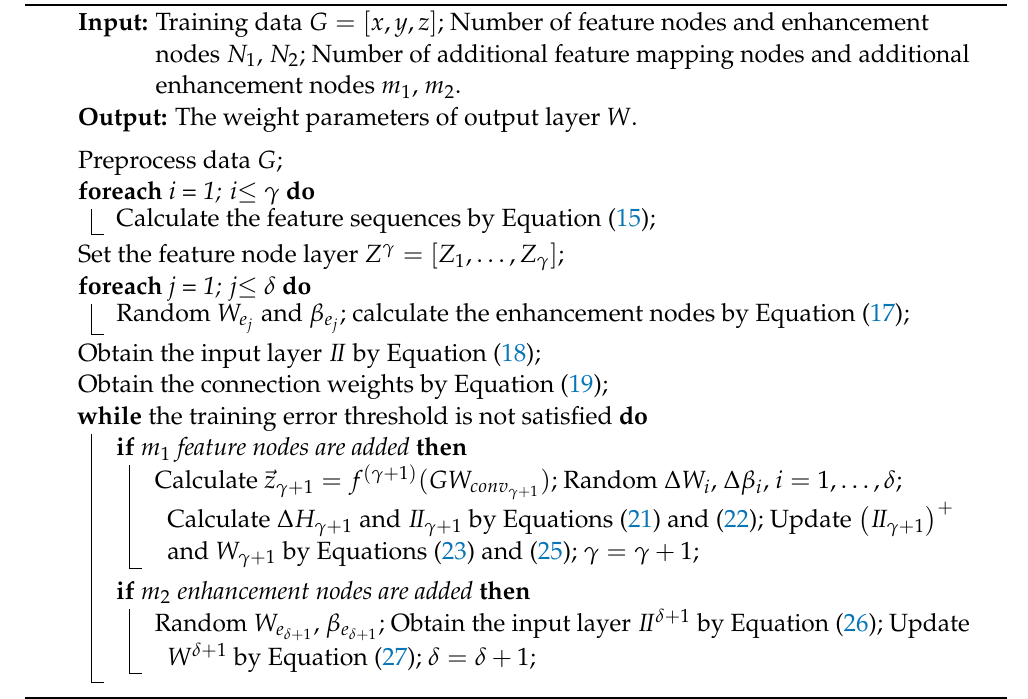
Figure 7. Network structure of CNN-BLS. Algorithm 1: Convolutional Broad Learning Filter Algorithm: Increment of Feature Mapping Nodes and Enchancement